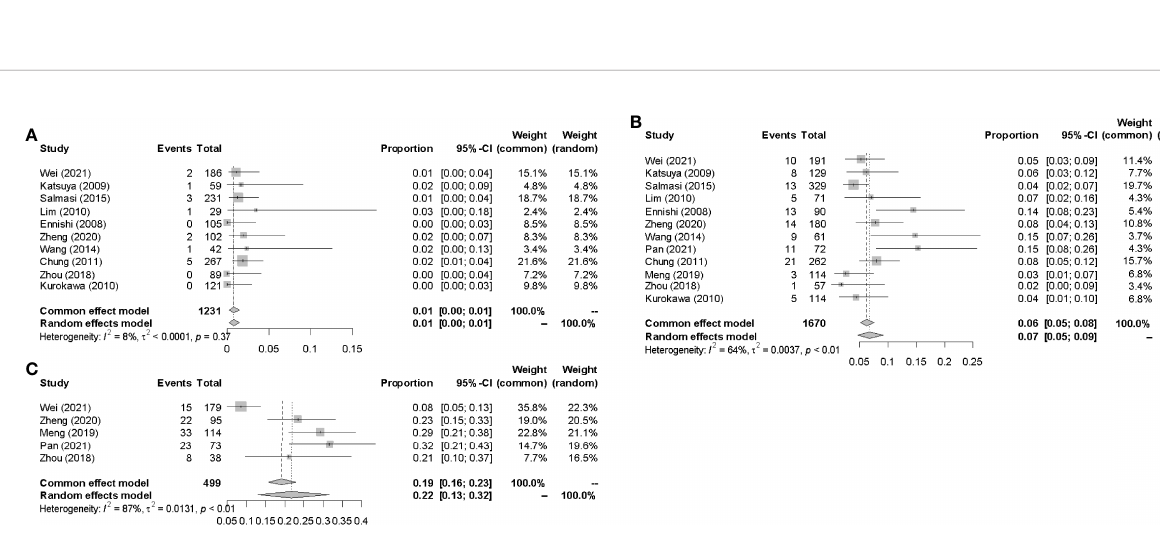
FIGURE 5 | Incidences of IP in CHOP-like regimens. (A) CHOP. (B) R-CHOP. (C)